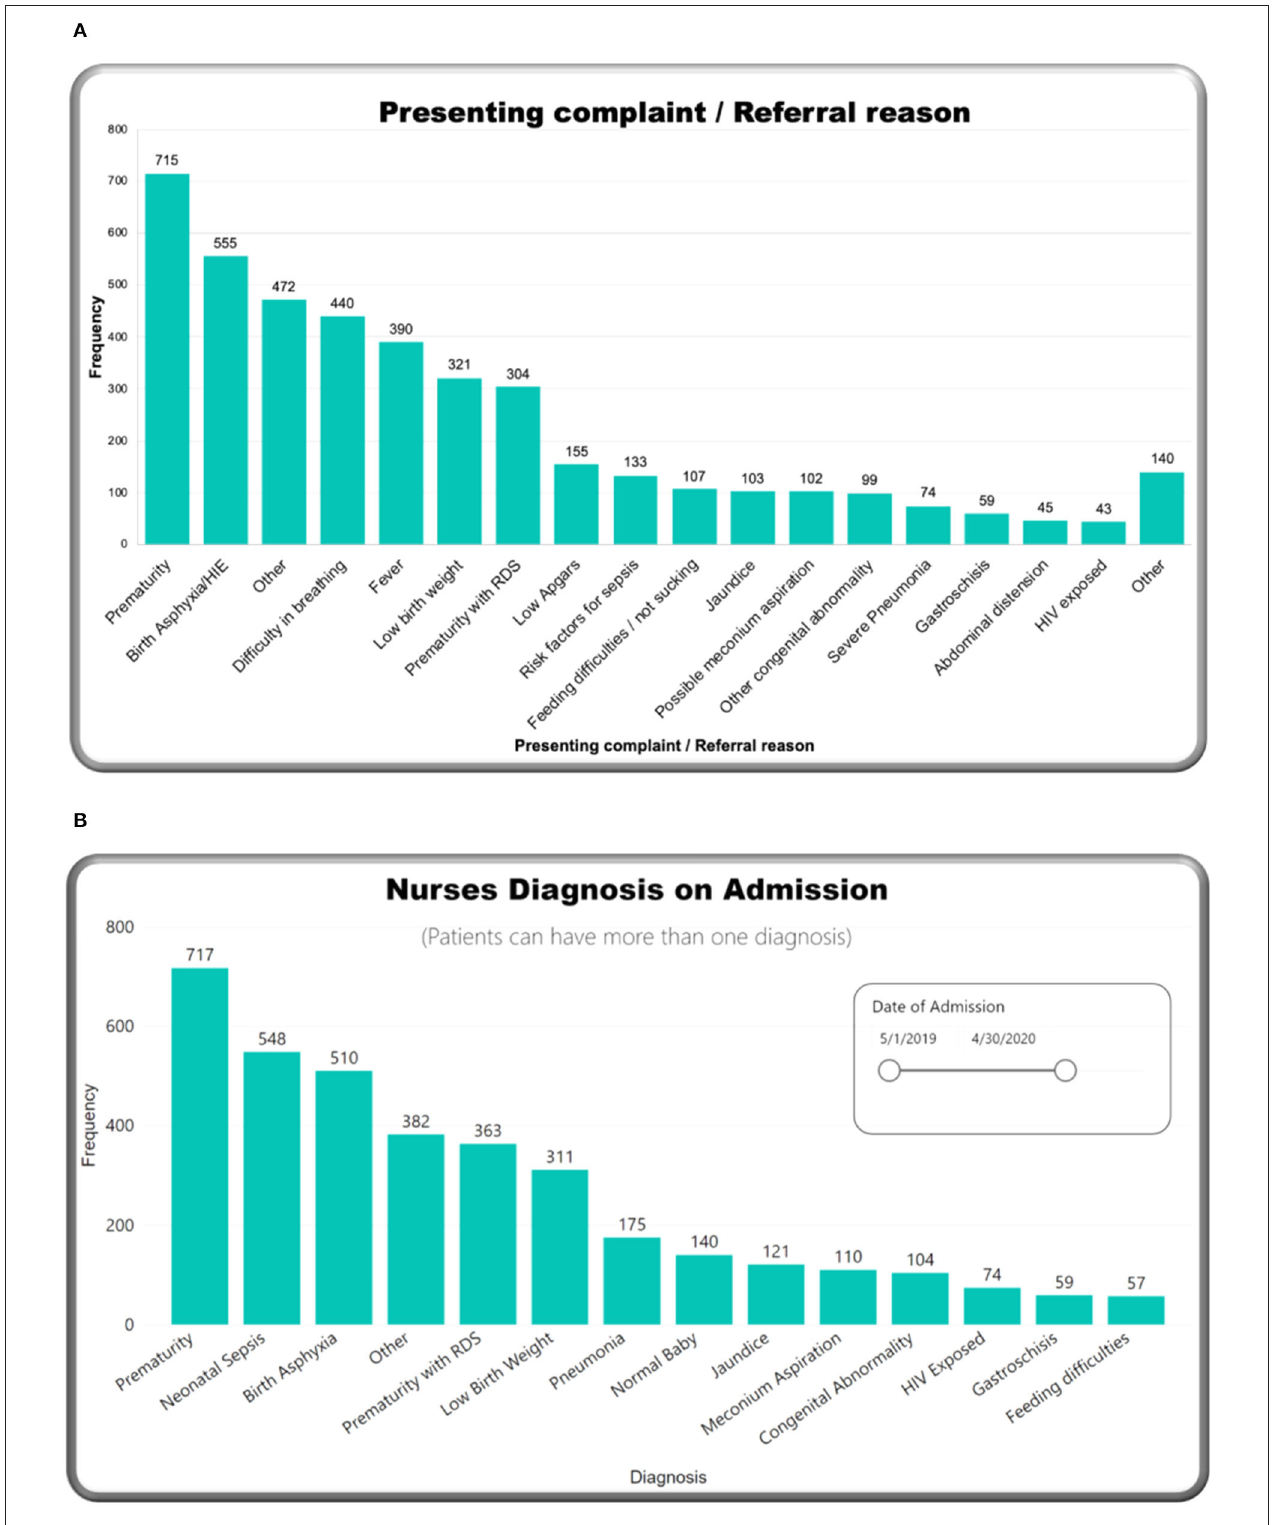
FIGURE 3 | M&M dashboard visuals: (A) Presenting complaint/referral reason, (B) nursing diagnosis at admission.